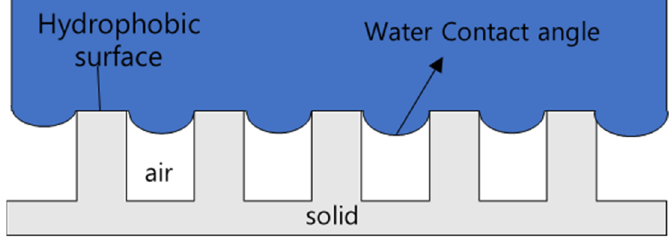
Figure 1. Schematic diagram of the superhydrophobic